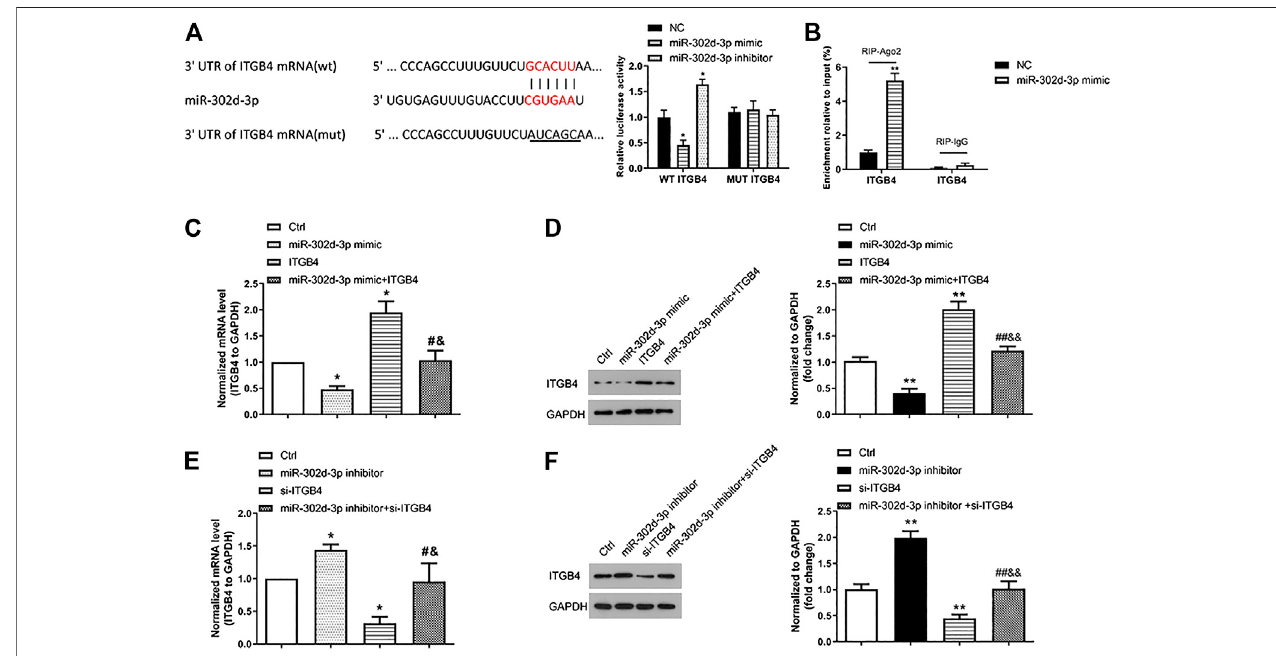
FIGURE 3 | ITGB4 is a direct target gene of miR-302d-3p. (A) Sequence alignment between miR-302d-3p and 3 ′ -UTR ITGB4. A dual-luciferase reporter gene assay was performed to verify the relationship between them. * p < 0.05. (B) RIP assay was utilized to examine the enrichment degree of ITGB4 in IgG or Ago2 immunoprecipitation complex. ** p < 0.01. (C,D) Effect of miR-302d-3p mimic, pcDNA3.1-ITGB4, and miR-302d-3p mimic + pcDNA3.1-ITGB4 on the expression of ITGB4inCHON-001cellsusingqRT-PCRandwesternblottingexperiments.* p < 0.05, # p < 0.05, & p < 0.05. (E,F) ImpactofmiR-302d-3pinhibitor,si-ITGB4, and miR-302d-3pinhibitor+si-ITGB4ontheexpressionofITGB4inCHON-001cellswasexaminedwithqRT-PCRandwesternblotassays.* p < 0.05, # p < 0.05, & p < 0.05. Results represent the mean of three independent experiments. Errors bars indicated mean ± SD (ANOVA followed by Tukey ’ s post hoc test).